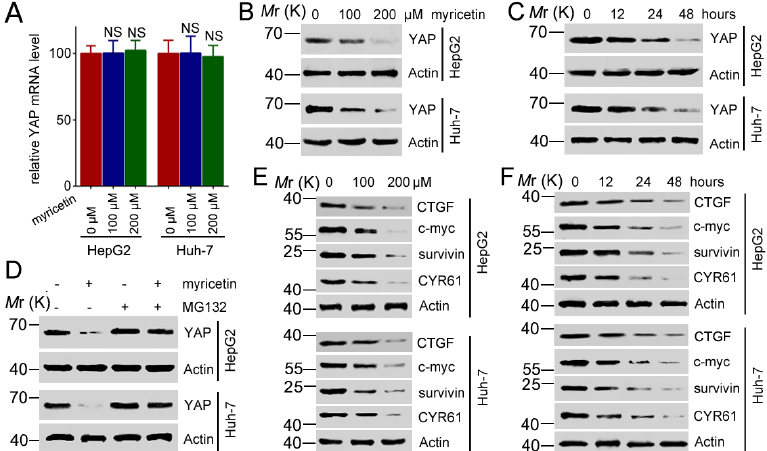
Figure 3. Myricetin stimulates degradation of YAP and inhibits CTGF, survivin, c-myc, and CYR61. ( A ) HCC cells were treated with the indicated dose of myricetin for 48 h, followed by RT-PCR analysis of YAP transcription. YAP mRNA levels were normalized to GAPDH. Values represent the mean ± SD. n = 3, NS, not significant, compared to control group. ( B ) Cells were treated with myricetin for 48 h at the indicated doses, followed by Western blot analysis of YAP expression. ( C ) Cells were treated with 200 μM myricetin for the indicated periods, followed by Western blot analysis of YAP expression. ( D ) Cells were pretreated with 10 μM MG132 for 5 h, then treated with or without 200 μM myricetin for 72 h, followed by Western blot analysis of YAP expression. ( E ) Cells were treated with myricetin for 48 h at the indicated doses, followed by Western blot analysis of indicated protein expressions. ( F ) Cells were treated with 200 μM myricetin for the indicated periods, followed by Western blot analysis of indicated protein expressions.